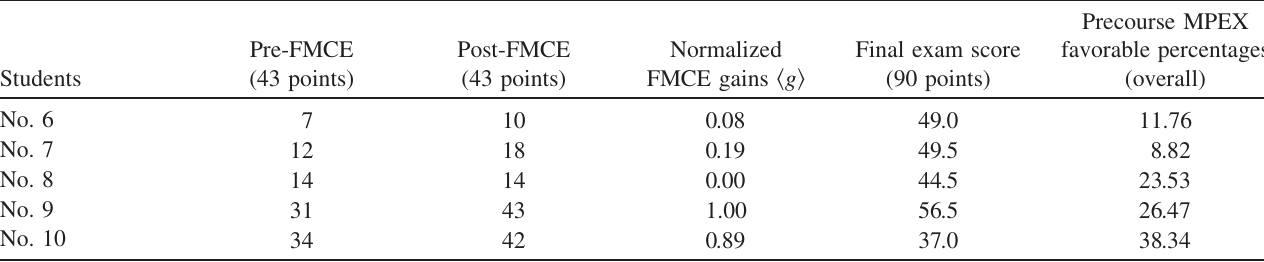
TABLE VI. Performances of students with low favorable precourse effort expectations.